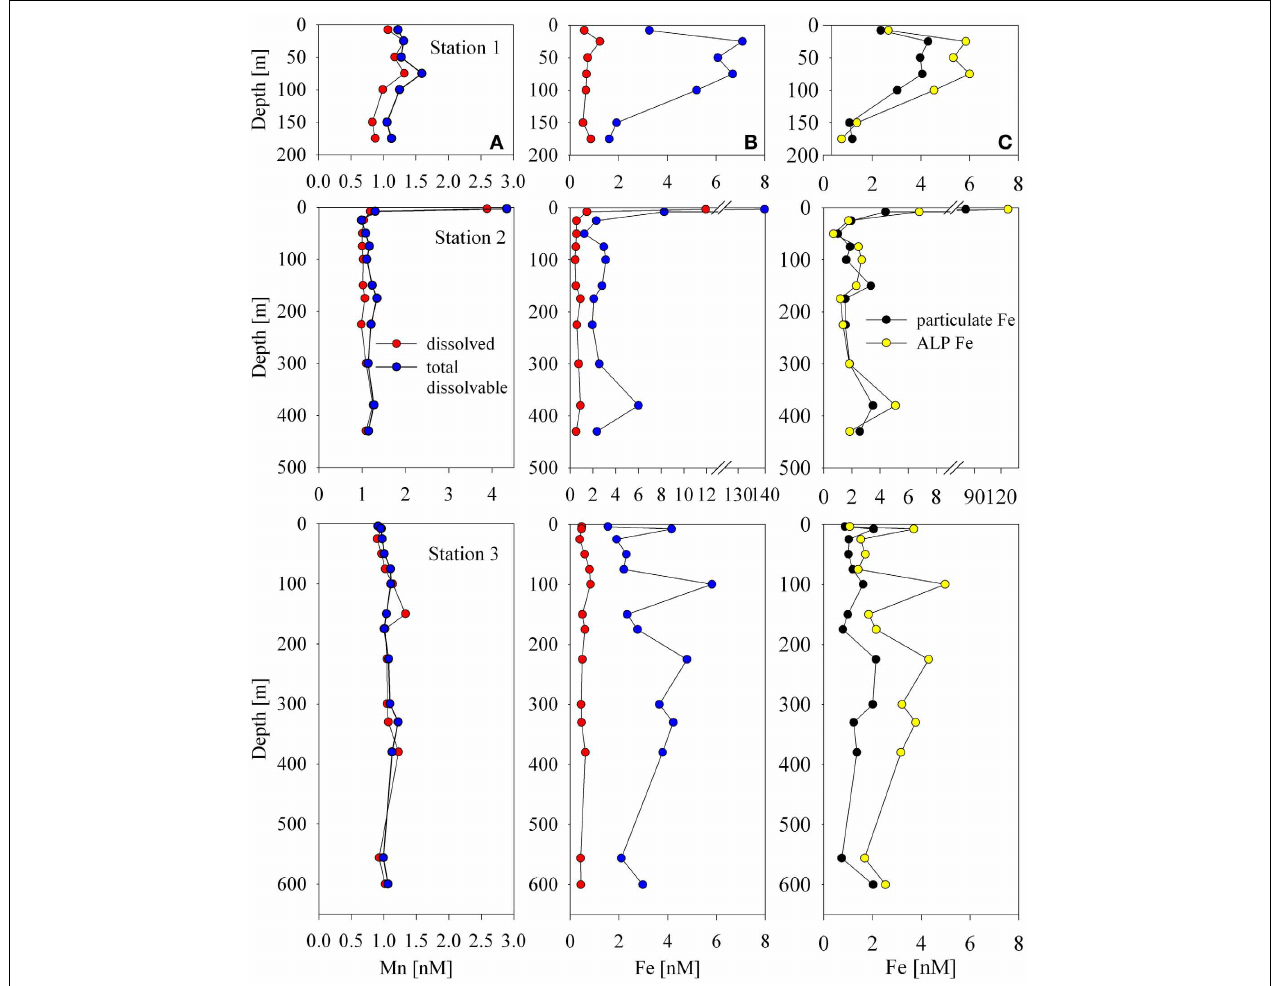
FIGURE 7 | A comparison of total dissolvable to dissolved manganese (panel A profiles) and total dissolvable to dissolved iron (panel B profiles). The acid leachable particulate concentration is determined by the difference between these two concentrations. This demonstrates that the